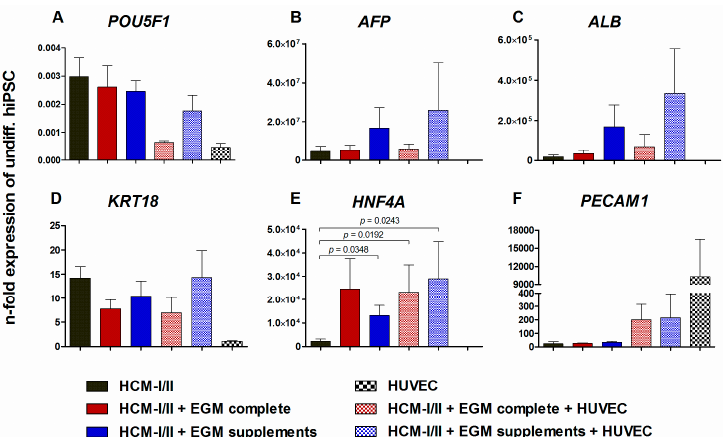
Figure 5. Effect of different media compositions and/or co-culture with human umbilical vein endothelial cells (HUVEC) on mRNA expression of stage-specific markers after hepatic differentiation of human induced pluripotent stem cells (hiPSC). Differentiation of definitive endodermal cells was performed over 14 days using hepatocyte culture medium (HCM-I/II), a 1:1 mixture of hepatocyte culture medium and endothelial cell growth medium, consisting of basal